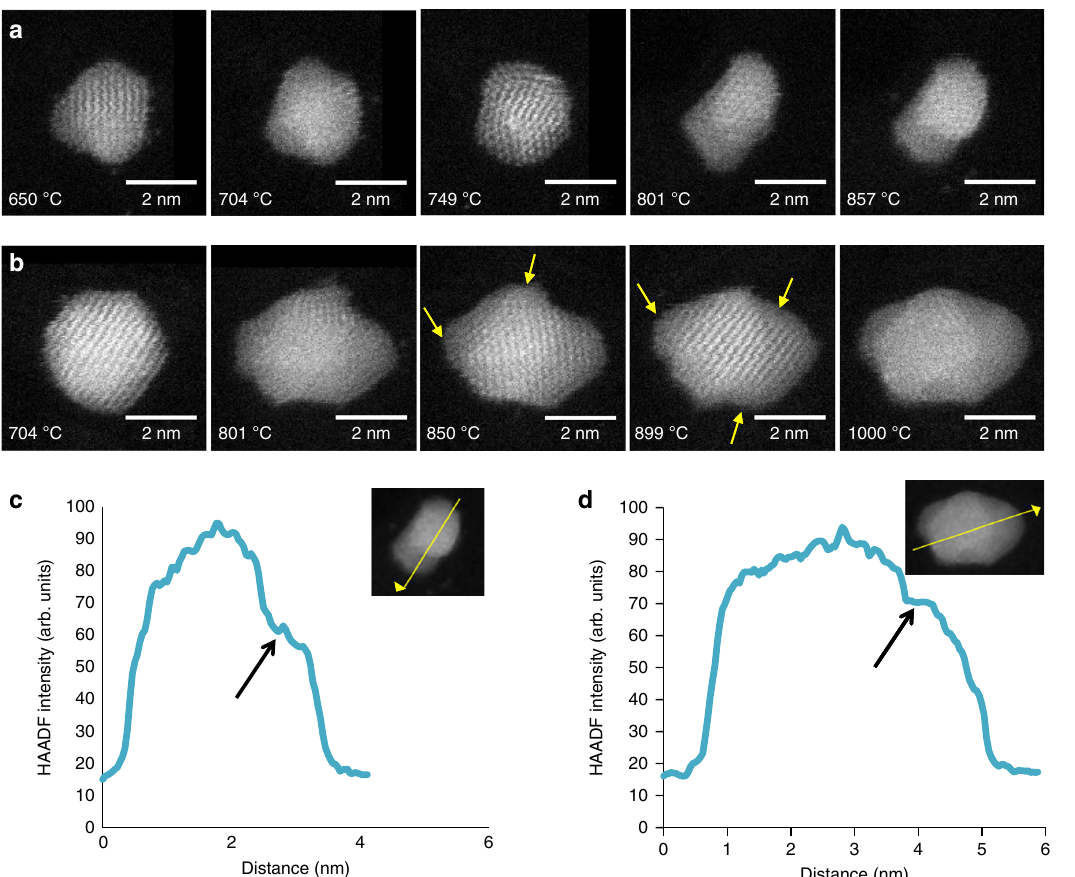
Fig. 4 The formation of a liquid shell in Au nanoclusters at high temperatures. a HAADF STEM images of an Au 561 particle at high temperatures (650 – 857 °C). b HAADF STEM images of an Au 1110 particle at high temperatures (704 – 1000 °C). Amorphous regions at the edges of the particle are highlighted by yellow arrows. c A line pro fi le plot of the HAADF intensity across the particle in ( a ) at 857 °C and d a line pro fi le plot of the HAADF intensity across the particle in ( b ) at 1000 °C. Black arrows on the HAADF intensity plots illustrate amorphous regions. Yellow arrows on the inset HAADF images indicate the direction and location of the line pro fi